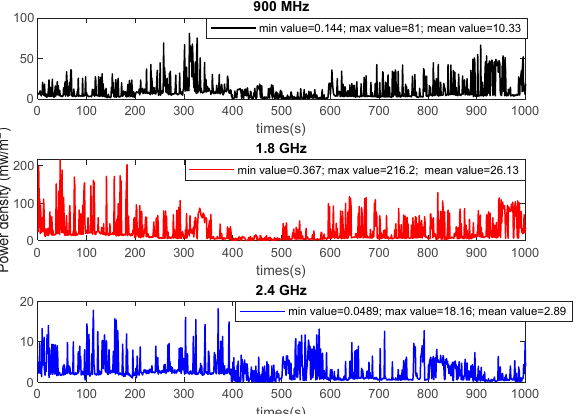
Figure 22. Variation in ambient power density in the 900 MHz, 1.8 GHz and 2.4 GHz bands.